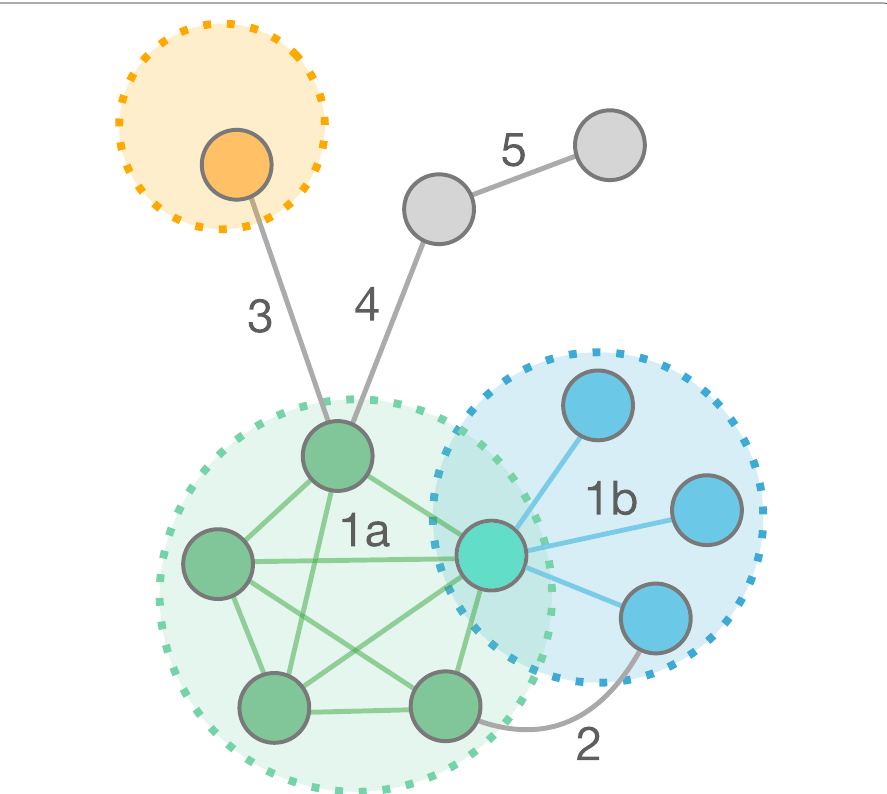
Fig. 5 Edges can be classified into five types : (1) intra-community edges; (2) inter-community edges between two overlapped communities; (3) inter-community edges between two communities that do not overlap; (4) edges between vertices with membership m > 0 and isolated vertices ( m = 0); (5) edges between isolated vertices. Focusing on the outbound edges of the green community with 5 members (circled), the edges 1b, 2, and 3+4 correspond to categories E 1, E 2, and E 3 outbound edges of the green community, respectively, as defined in the text. Different from the five types which classify edges of the whole network, the three categories E 1, E 2, and E 3 are used to classify the outbound edges of a community and thus are introduced from the viewpoint of a particular community. There are some overlaps between the two types of classification: (1) An E 1 outbound edge is by definition a Type 1 edge; (2) A Type 2 (Type 3) edge is also an E 2 ( E 3) outbound edge of the two corresponding communities that the edge connects. However, the